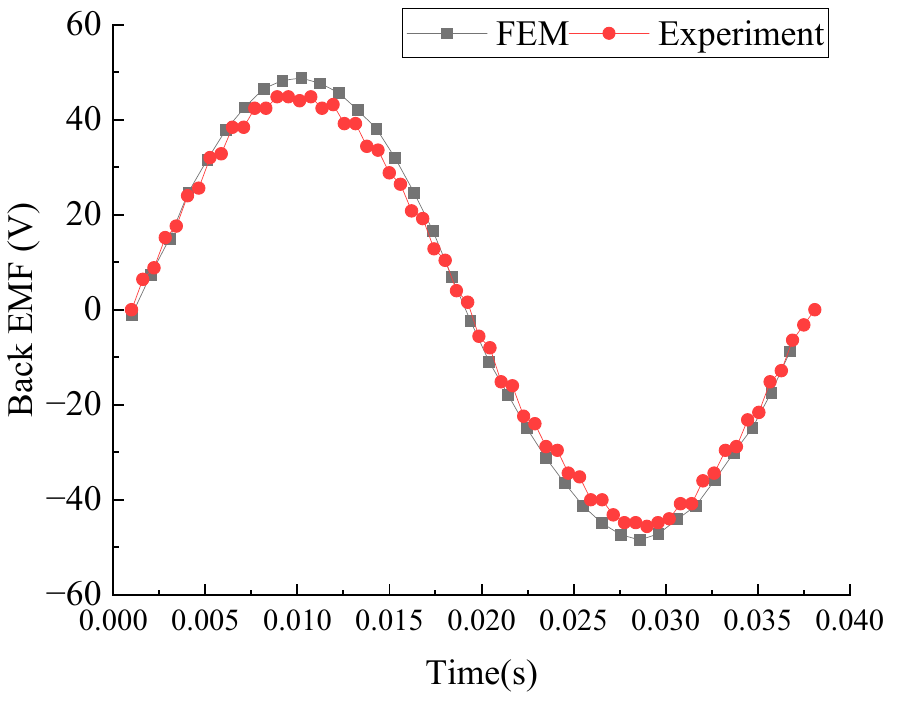
Figure 23. Comparison of waveforms of no-load back-EMF.